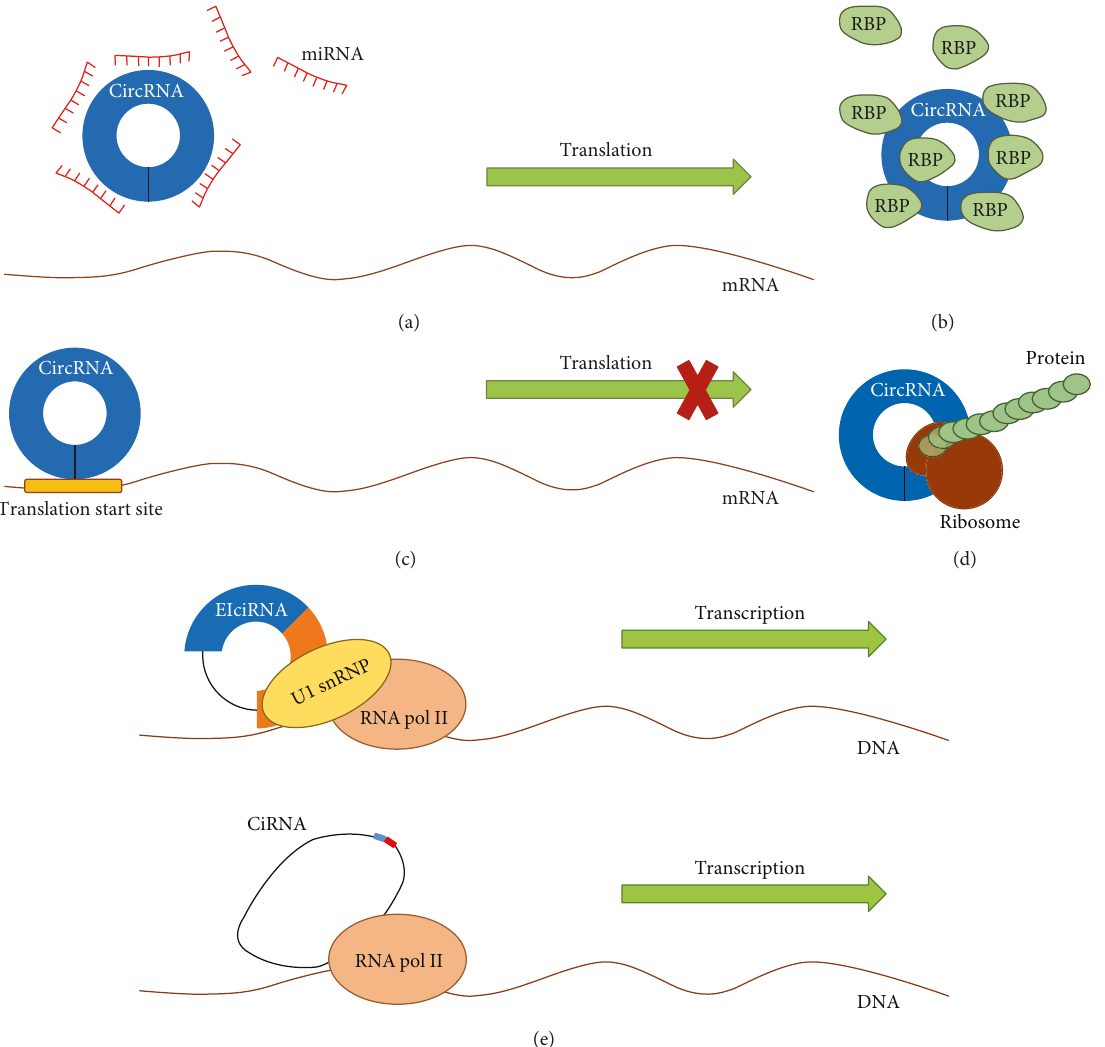
Figure 2: Schematic representation of circRNA functions. (a) CircRNAs may act as miRNA sponges by competing for miRNA binding sites, diminishing the e ff ect of miRNA-mediated regulatory activities. (b) CircRNAs may act as protein sponges, by binding RNA-binding proteins (RBPs). (c) Some circRNAs may regulate protein expression by sequestering mRNA translation start sites. (d) CircRNAs may be translated to form functional proteins. (e) CircRNAs (e.g., EIciRNAs and ciRNAs) may interact with transcription complexes and enhance the expression of their parental